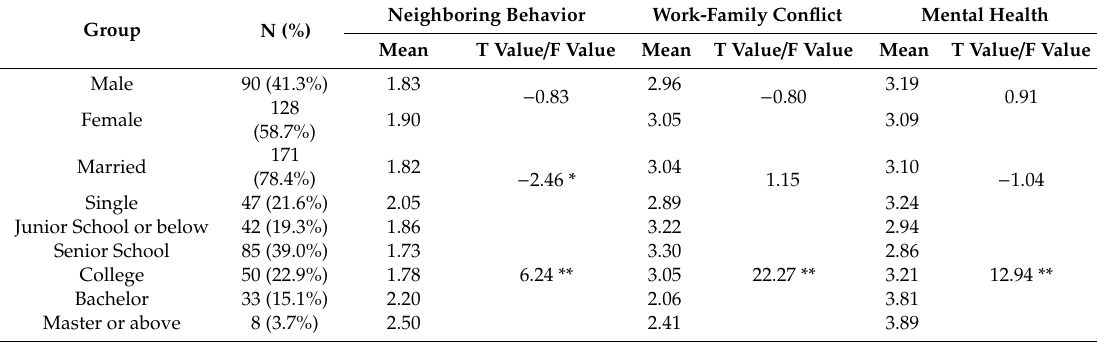
Table 3. Demographic Characteristic of Neighboring behavior, Work-Family Conflict and General Health.